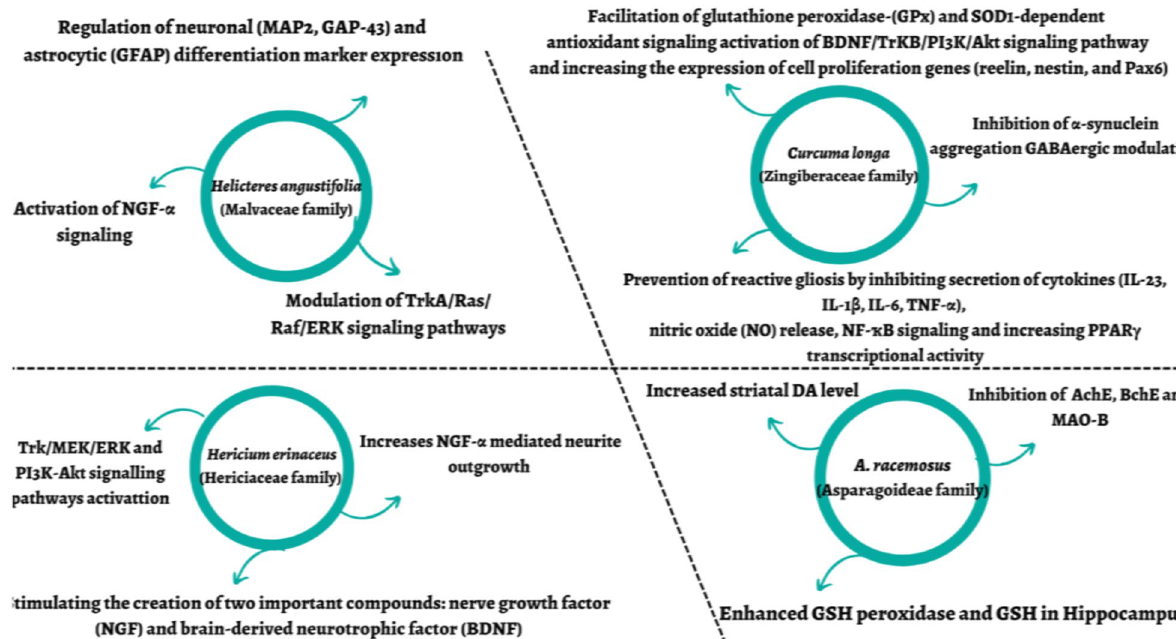
Fig. 5 Neuroprotective mechanism of action of the neuro-nutraceutical herbs